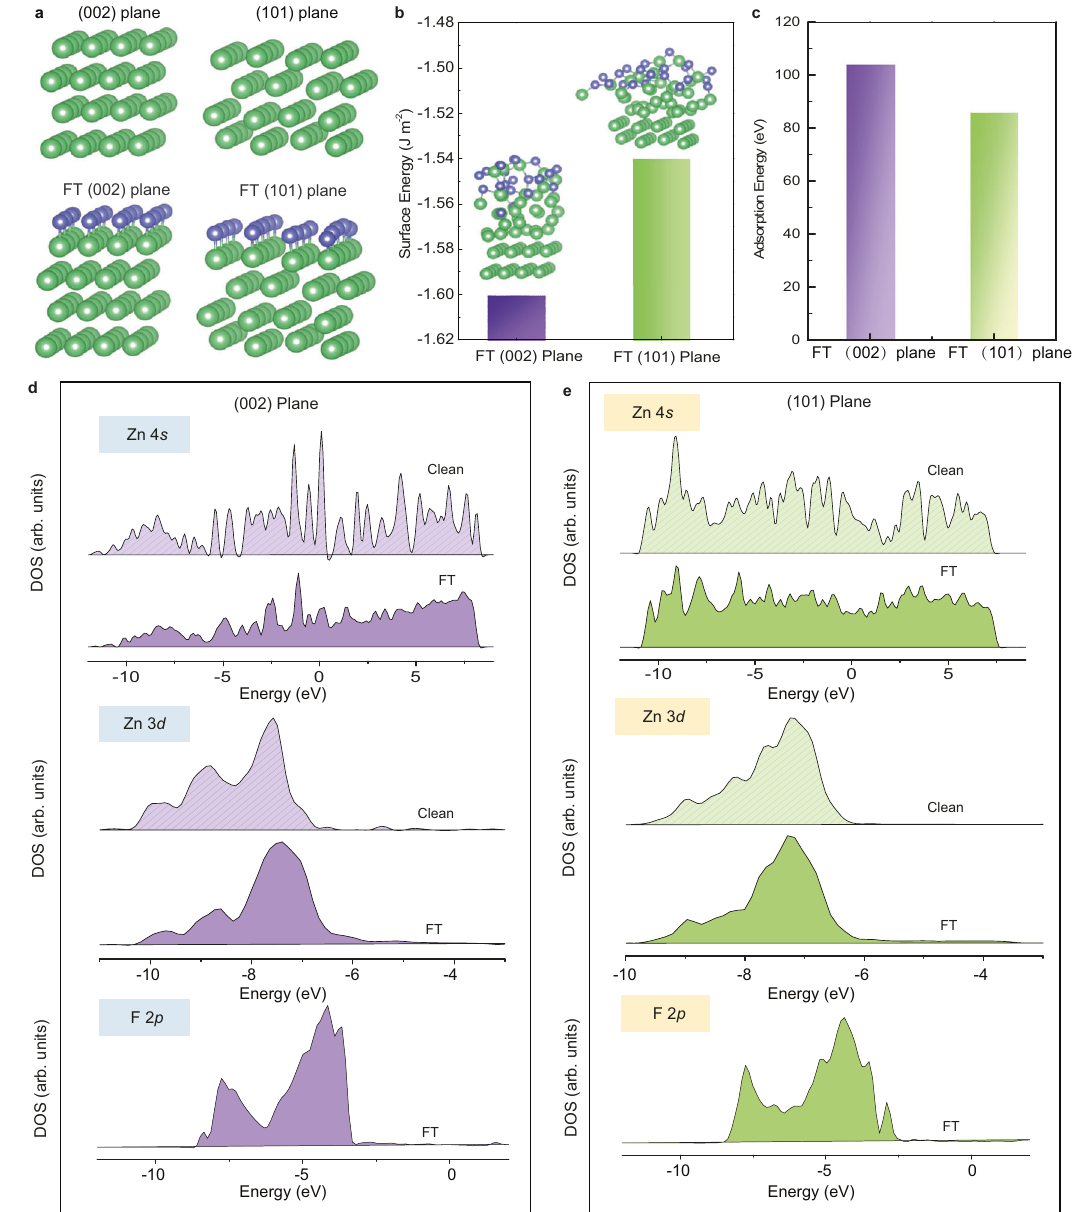
Fig. 6 Theoretical simulation of FT-Zn (002) and FT-Zn (101). a Calculations models of F atom adsorbed on Zn (002) and Zn (101). Calculated b free energies and c adsorption energies of F atom on Zn (002) plane and Zn (101) plane. d , e Calculated projected density of states (PDOS) for clean Zn and FT-Zn